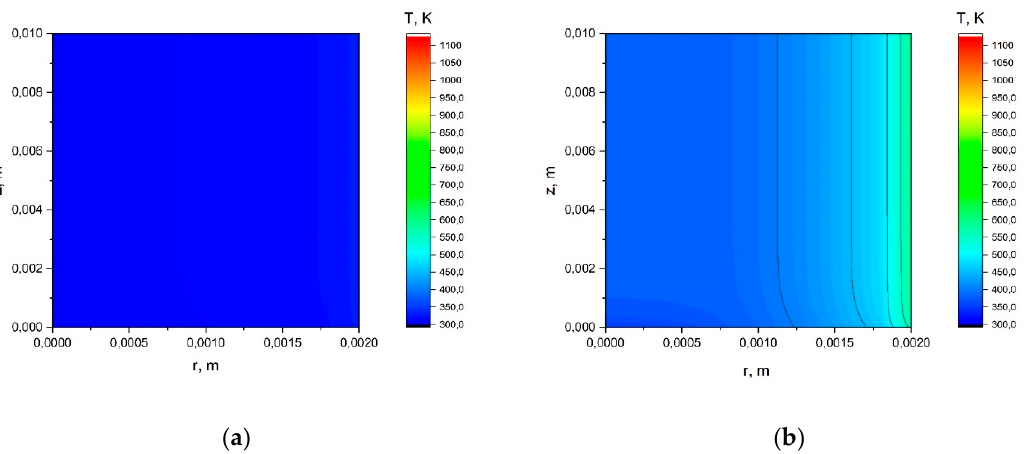
Figure A3. Temperature distribution in the stem of a herbaceous plant: R = 0.002 m, t = 3 s, q = 3 kW/m 2